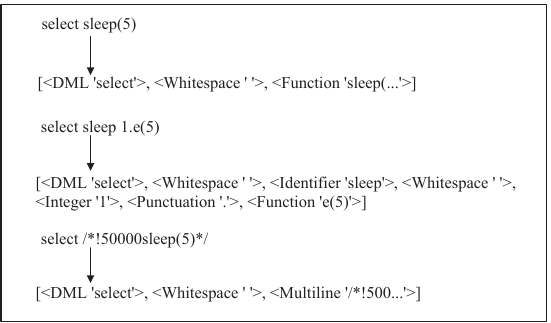
Figure 4. MySQL execution results for two coding strategies.